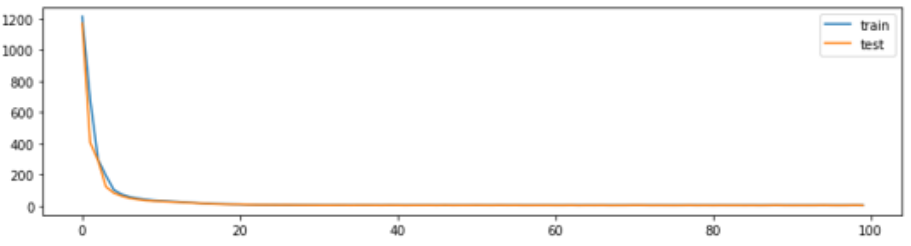
Figure 6. Example of learning curve, showing the loss measured during training of an LSTM